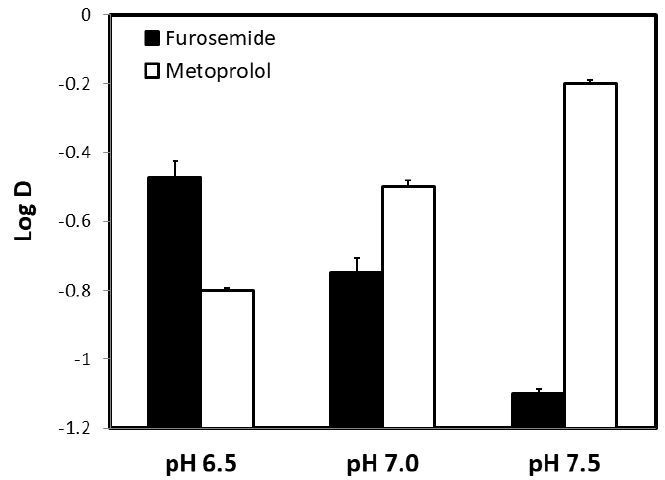
Figure 1. The octanol-buffer partition coefficients, Log D, for furosemide and metoprolol at the three